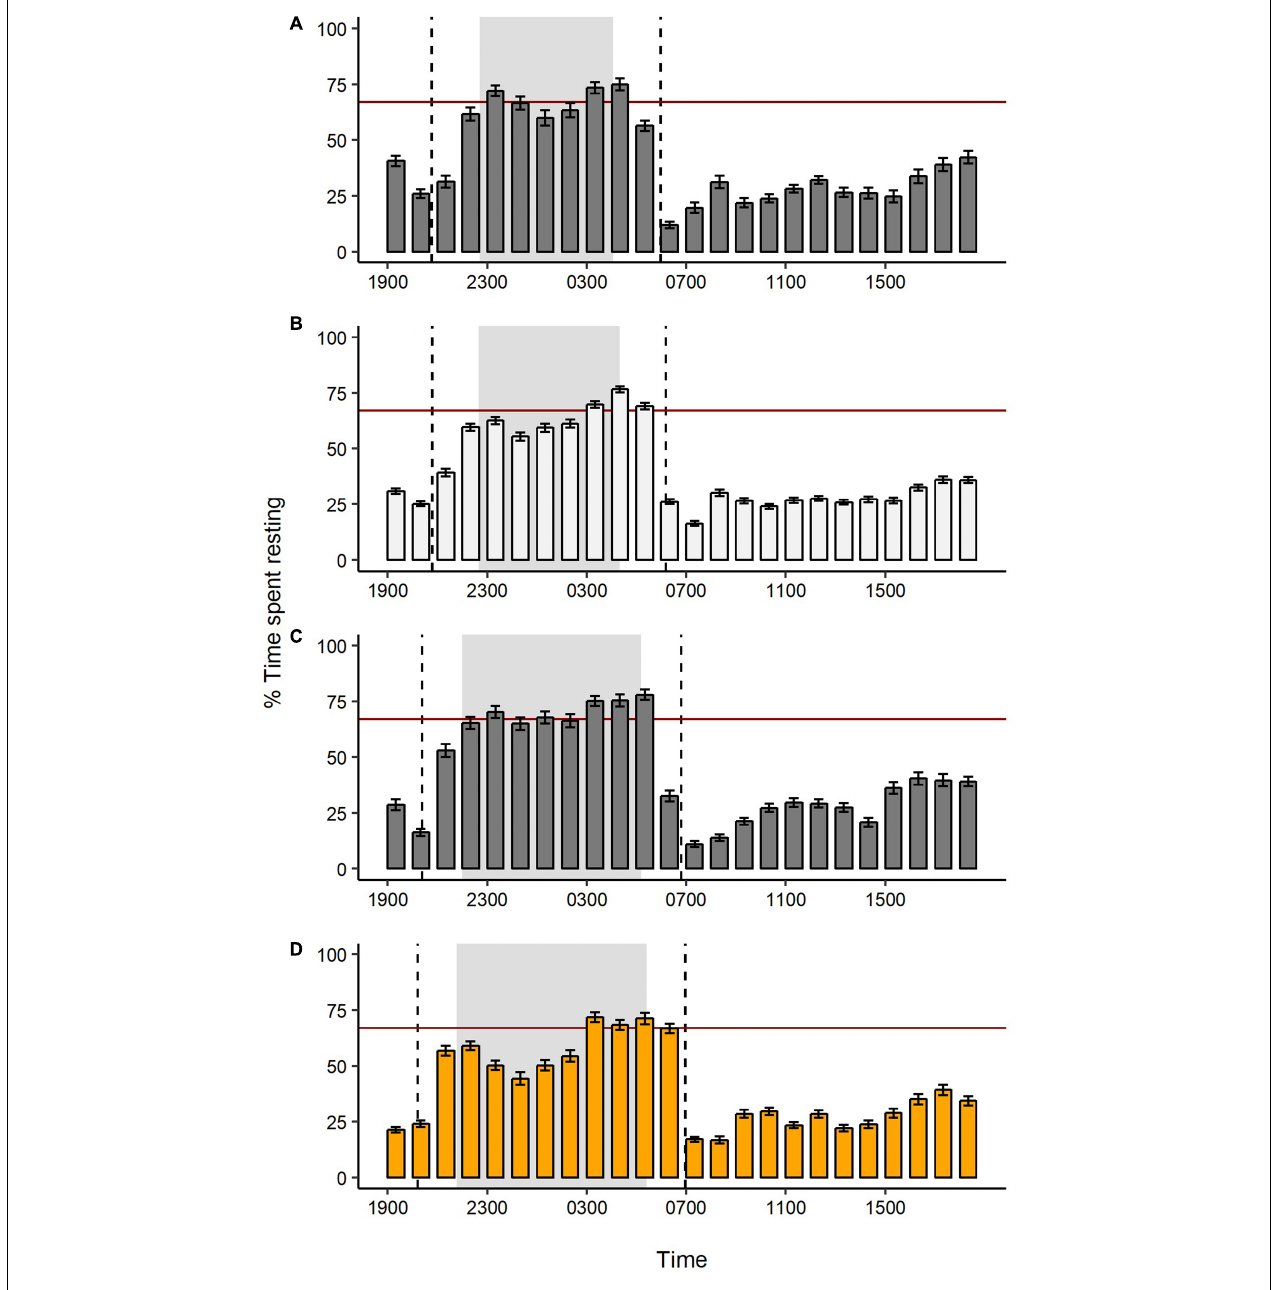
FIGURE 3 | Percentage of time swans spent resting each hour (mean ± SE) during four consecutive light treatments: (A) first dark control, (B) white light at night, (C) second dark control, and (D) amber light at night. Daylength decreased during the study, such that the earliest sunrise and latest sunset times for each treatment are marked by dashed vertical lines; astronomical night is shaded in gray. Mean night-time rest during the first dark control is marked for visual reference (red horizontal line at 67%).